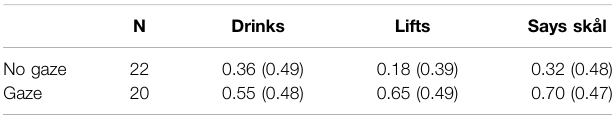
TABLE 1 | Means (and standard deviations) of participants drinking, lifting their glass, and saying “ skål ” in response to the robot ’ s utterance (Fischer et al,